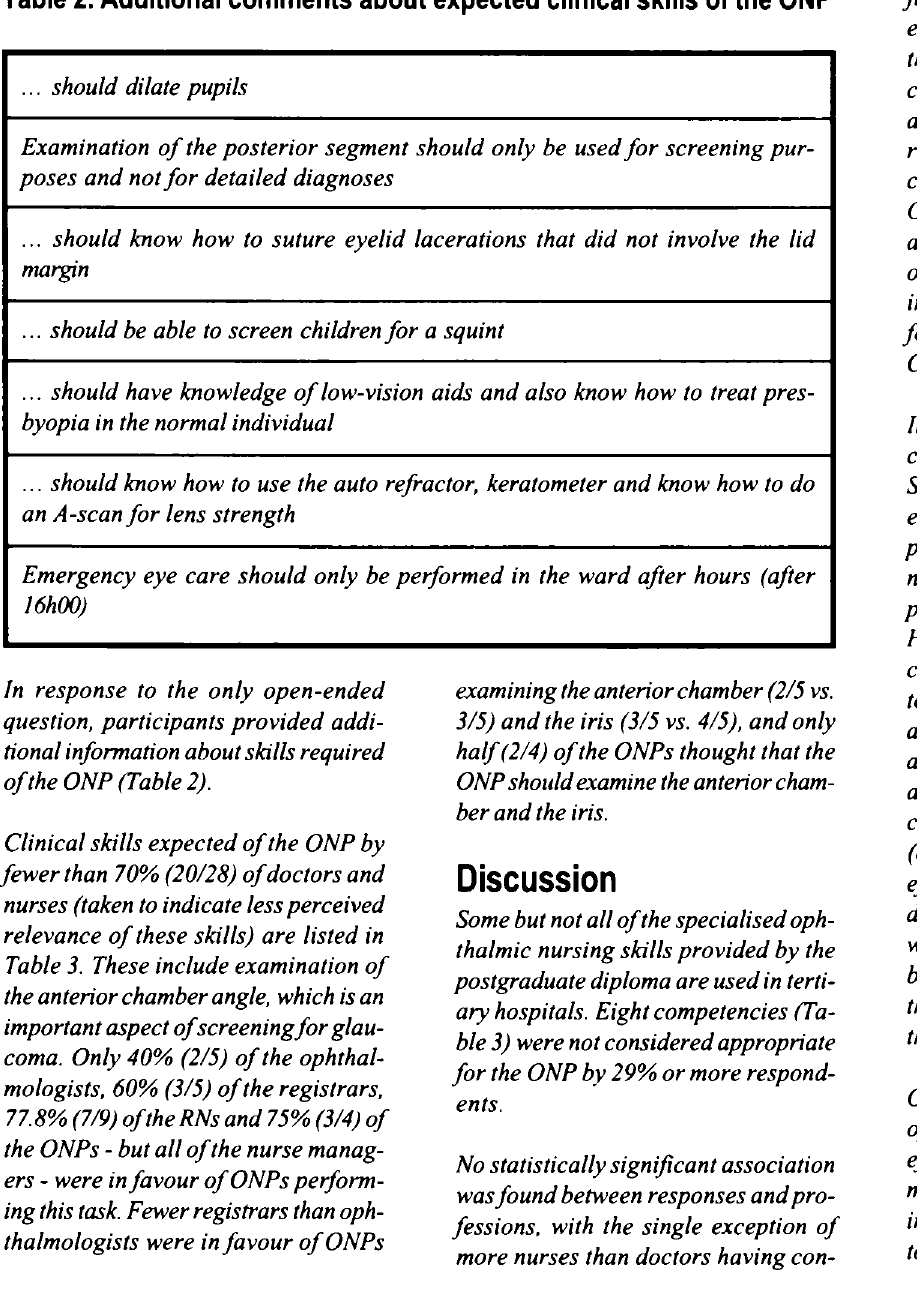
Table 3. Clinical skills not supported by 29% or more respondents